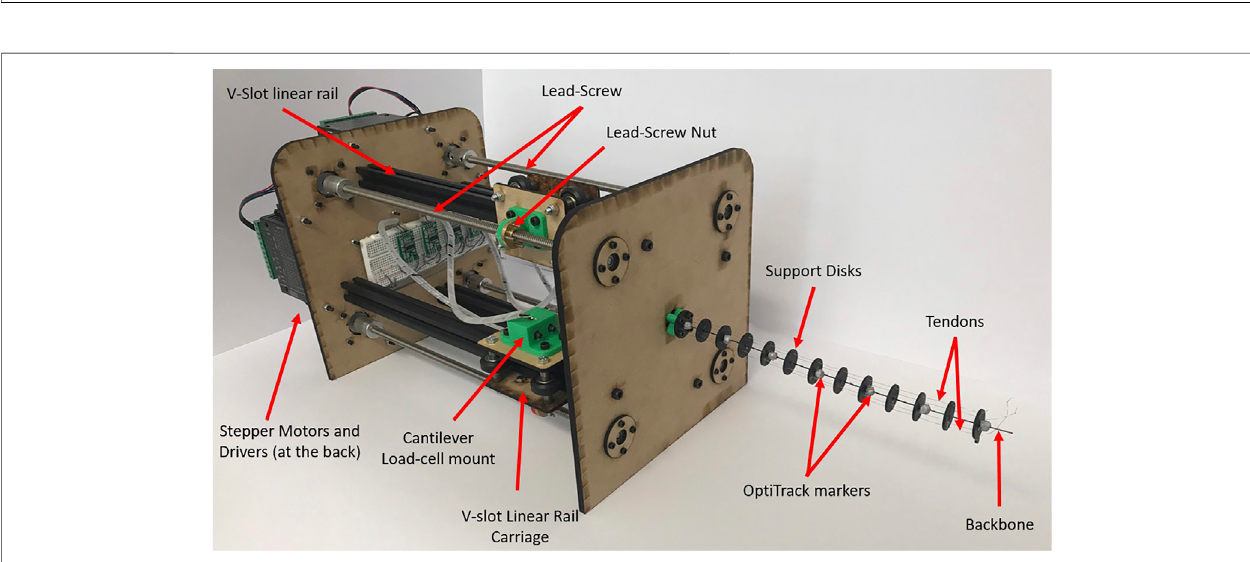
FIGURE 2 | Constructed continuum robot rig with backbone, actuated by tendons running through support disks by stepper motor and lead screws. Cantilever load-cells measure the tendon tension and OptiTrack markers are included for backbone position detection.